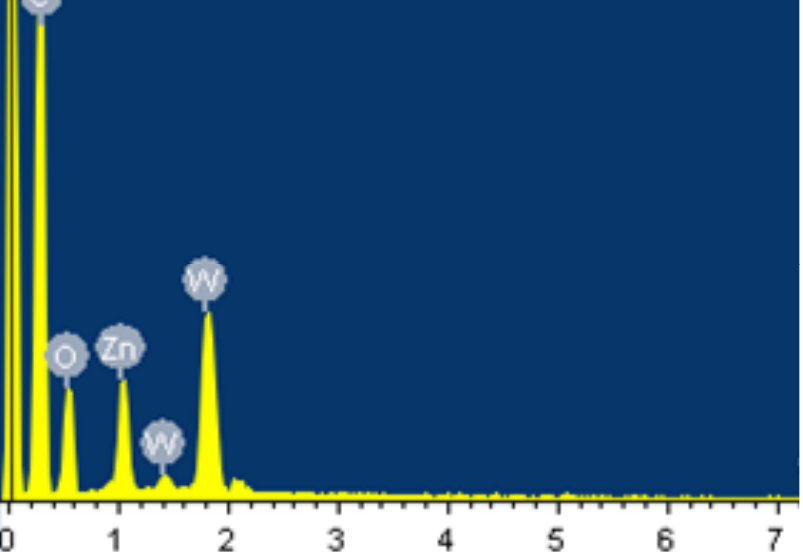
Figure 3. EDS study of ZnWO 4 -NPs@rGO nanocomposites for elemental analysis.